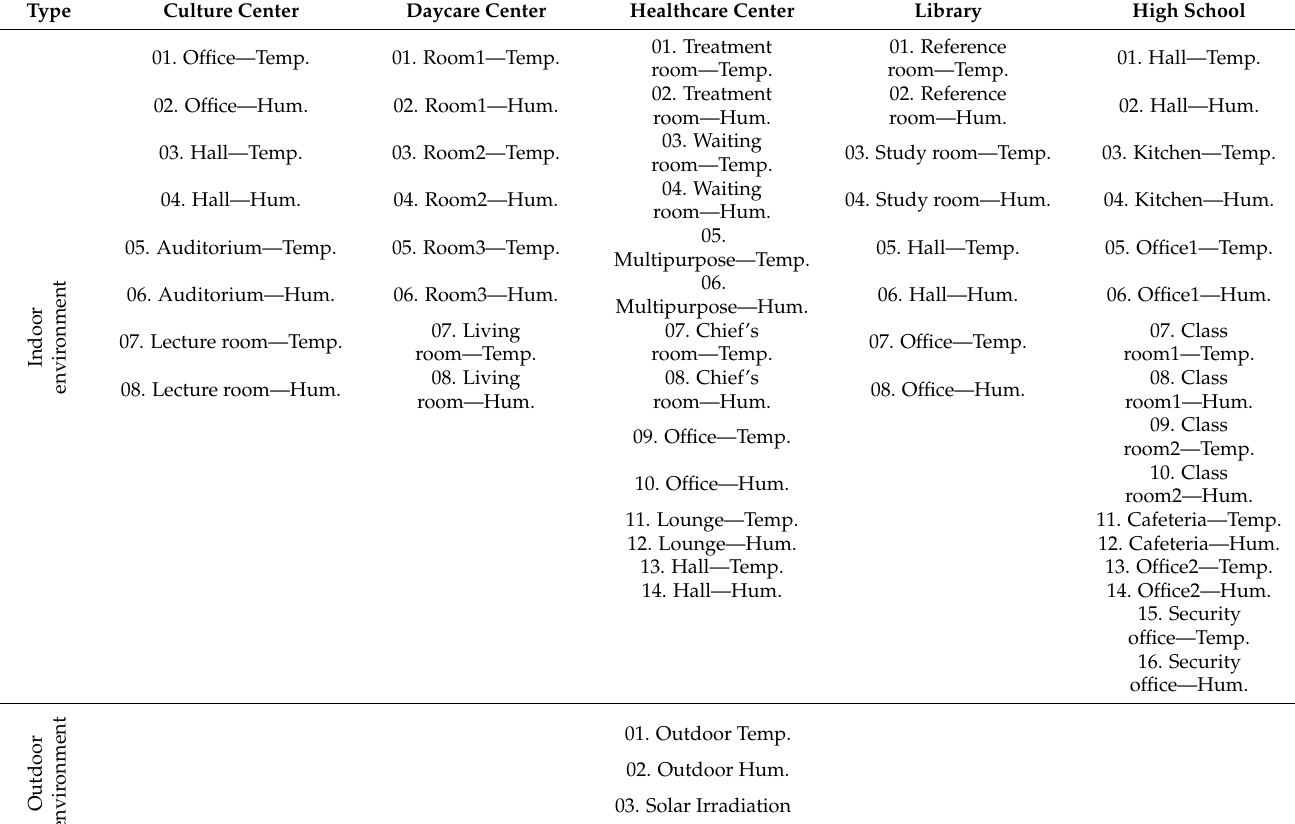
Table 2. A list of input data for each case. (Temp. is indoor temperature and Hum. is indoor humidity).